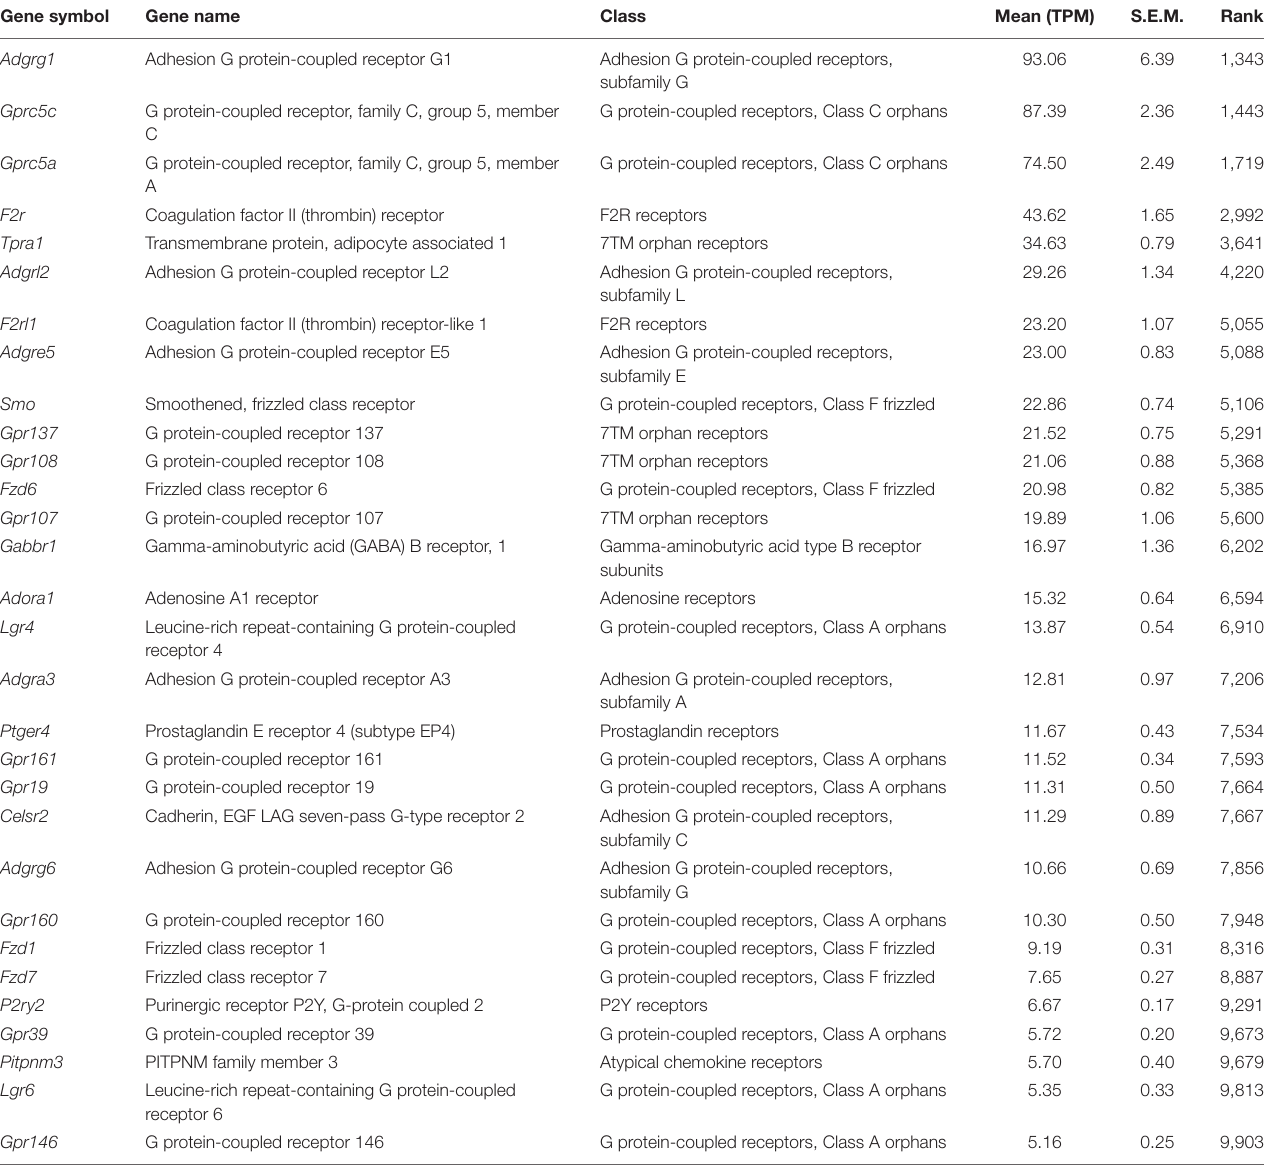
TABLE 4 | Top 30 GPCRs (see the full GPCR list in Supplementary Table 1